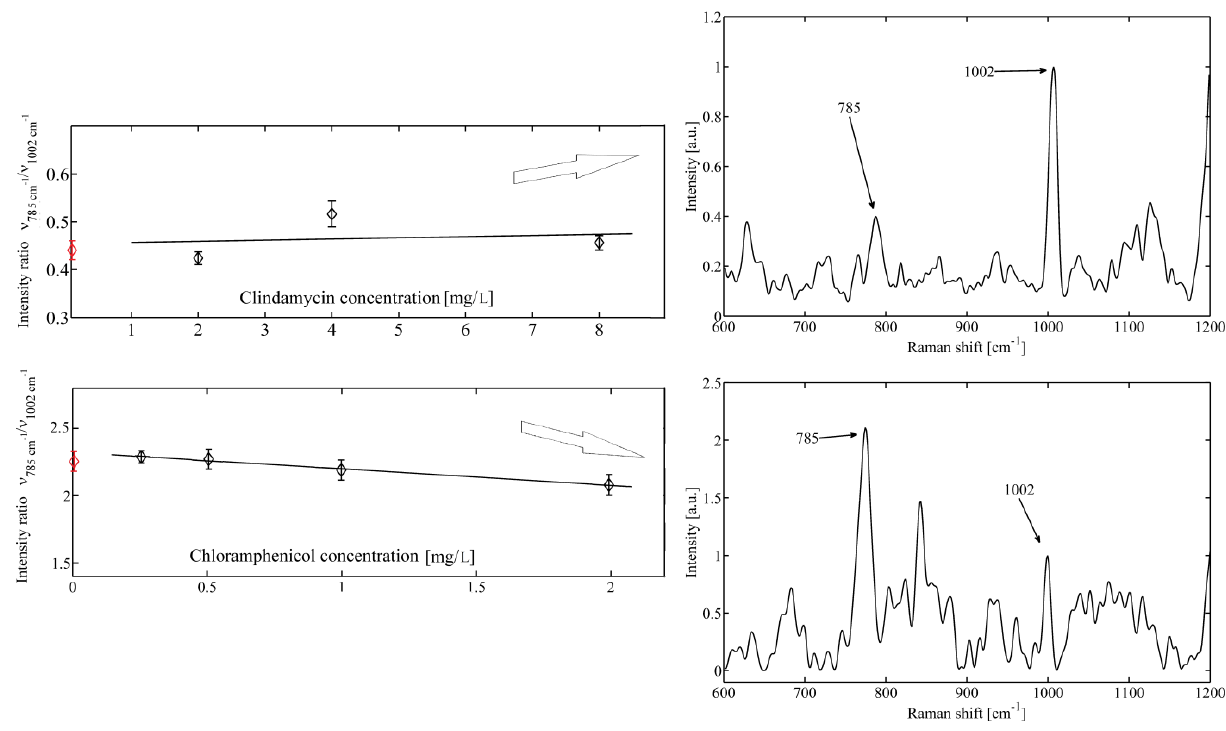
Figure 4. Mean value of bacteria response to bacteriostatic action of ( a ) top–clindamycine and ( b ) bottom–chloramphenicol, on cells of Staphylococcus epidermidis . Constant intensity ratio indicates for both antibiotics no visible influence on bacterial DNA. Raman spectra for control samples are shown on the right (indicated with red